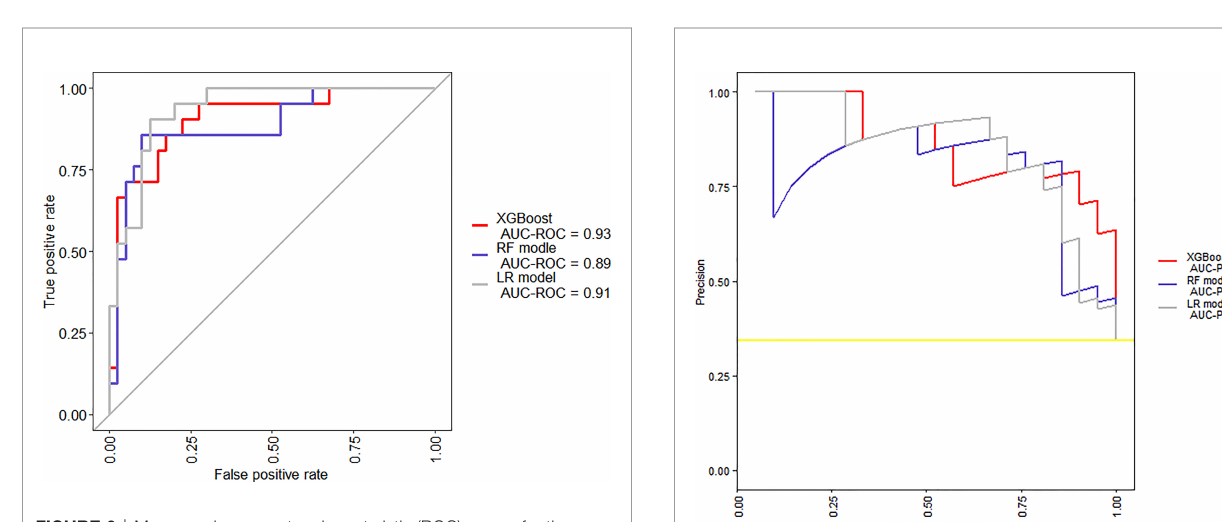
FIGURE 6 | Mean receiver operator characteristic (ROC) curves for the XGBoost, RF model, and LR model.